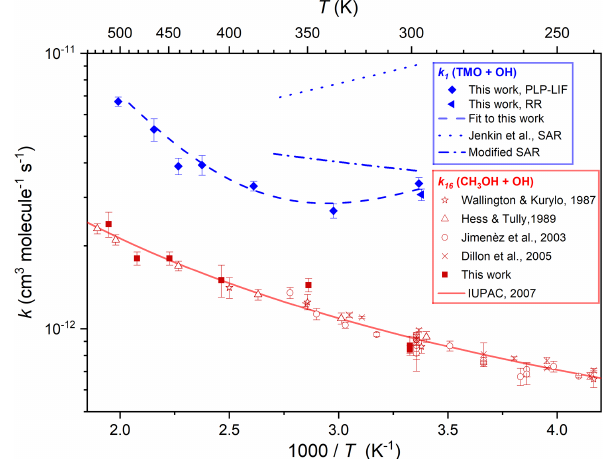
Figure 6. Arrhenius plot displaying k 1 ( T ) results from this work obtained via PLP–LIF (filled blue diamonds) and RR (filled blue triangle) all fit with the four-parameter expression, Eq. (4), to yield k 1 (294–502K) = 5 . 33 × 10 − 10 exp( − 2237 /T ) + 2 . 22 × 10 − 13 exp( + 766 /T )cm 3 molecule − 1 s − 1 (the dashed blue line). Calculated k 1 (298–370K) using the SAR proposed by Jenkin et al. (2018) is displayed as the dotted blue line, whilst the dotted–dashed blue line represents a modified SAR calculation (see Sect. 3.4). Also displayed are k 16 (299–501K) from this work (filled red squares) alongside literature determinations (Hess and Tully, 1989; Wallington et al., 1988; Jiménez et al., 2003; Dil- lon et al., 2005) and the most recent evaluation from IUPAC (Atkinson et al., 2006), recommending k 16 (210–866K) = 6 . 38